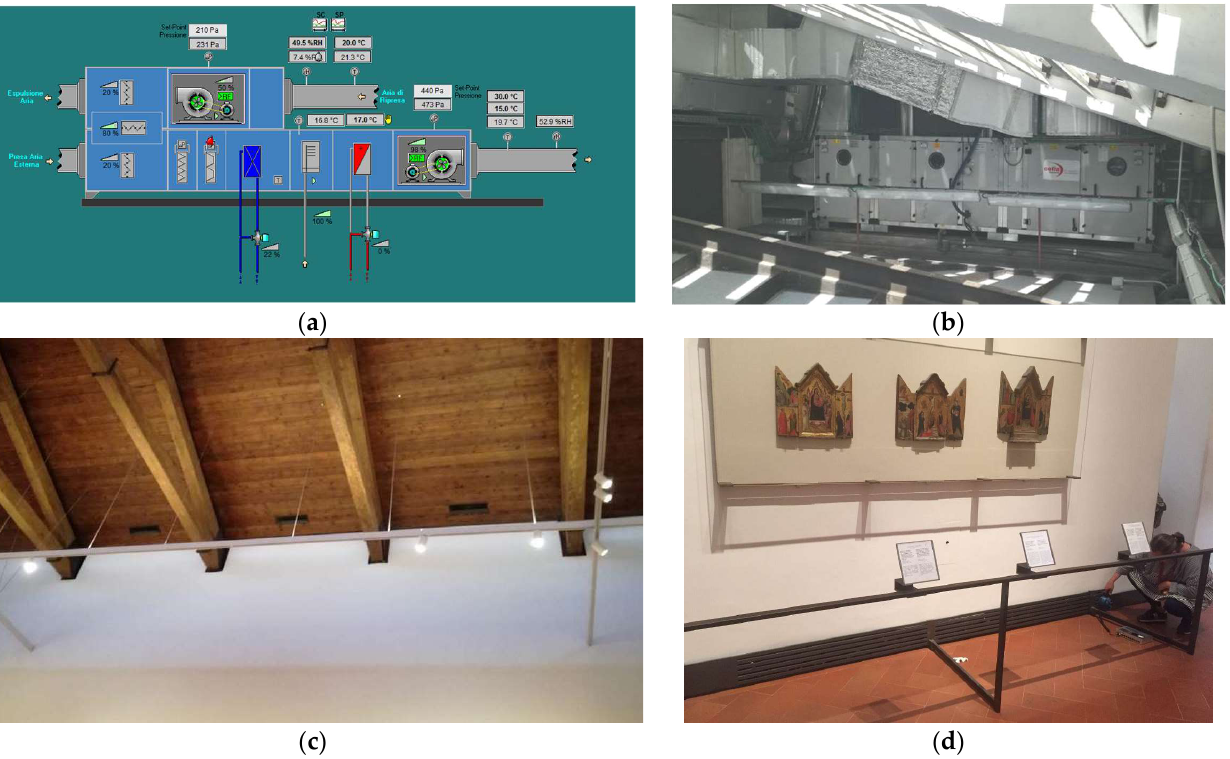
Figure 2. ( a ) AHU control system scheme, ( b ) AHU in the attic room, ( c ) air inlet grids from the top of the roof, and ( d ) air outlet grids at the bottom of the opposite wall of Room 2.